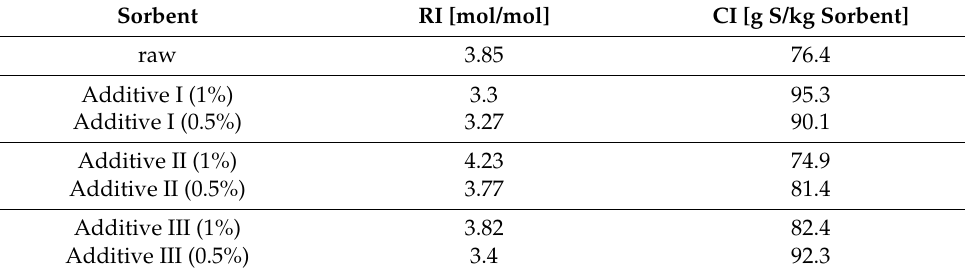
Table 5. Values of the reactivity coefficient RI and the absolute sorption coefficient